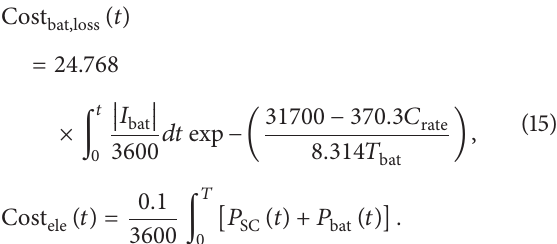
Figure 36: Energy loss of the semiactive topological structure described in Figure 4 for NEDC driving cycle.